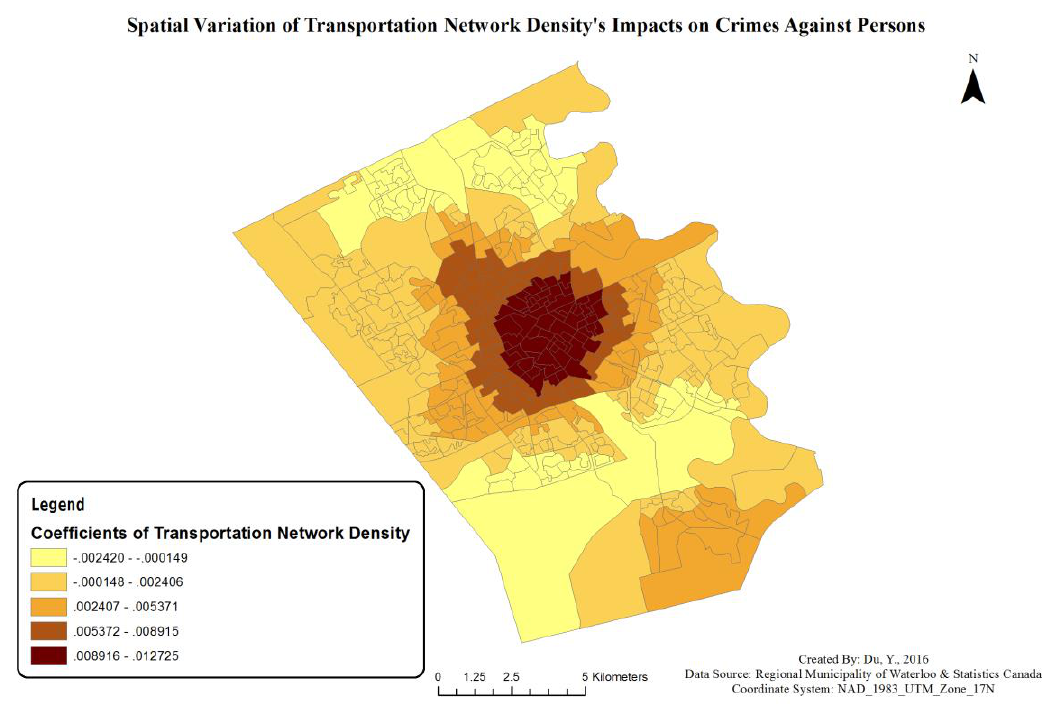
Figure 5. Transportation network density’s impact on crimes against persons.